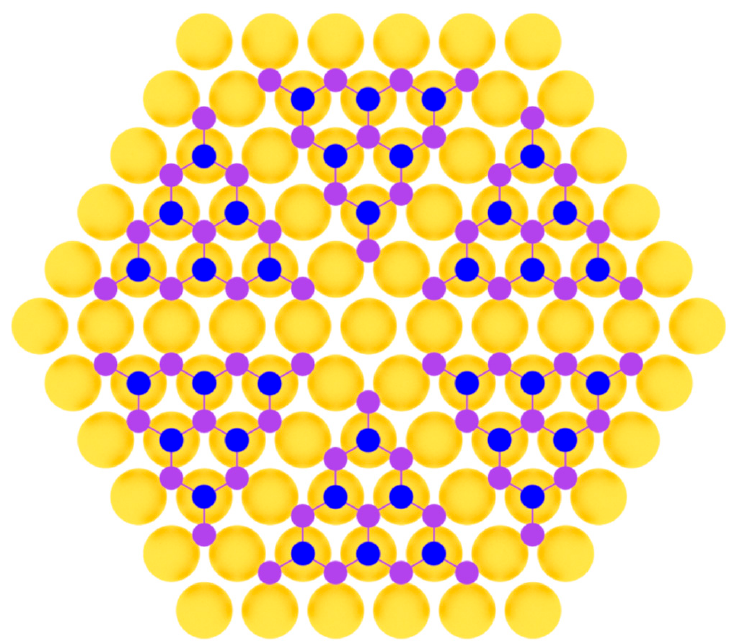
Figure 8. Model of phosphorene layer on a metal substrate (two colors are used for phosphorus atoms at different height positions).